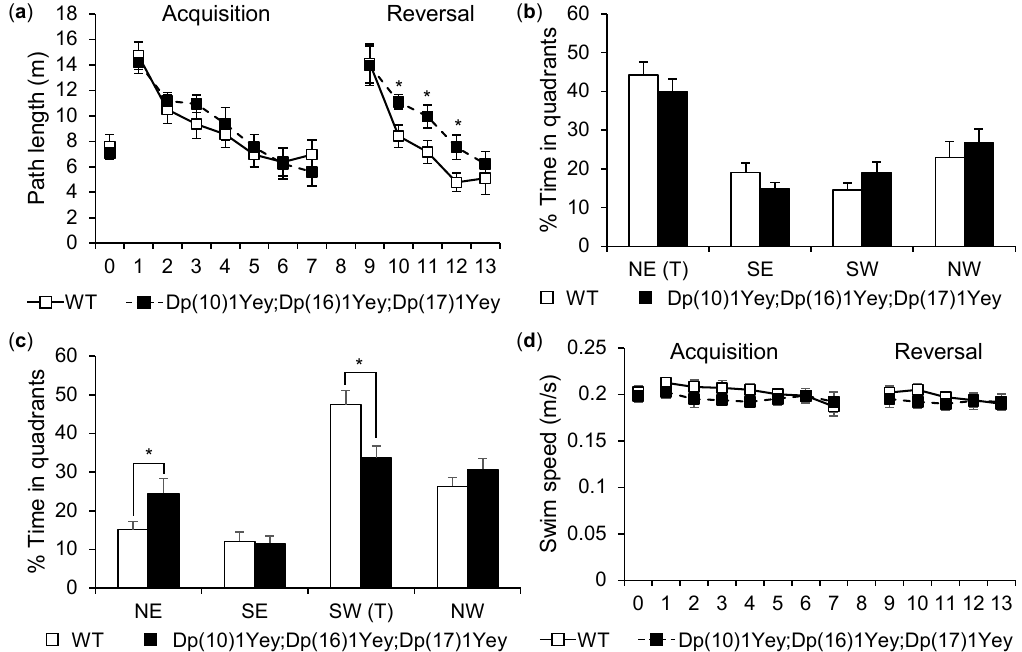
Figure 8. Morris water maze test: Dp(10)1Yey;Dp(16)1Yey;Dp(17)1Yey mice and the wild-type control mice were compared in a Morris water maze test. ( a ) During the hidden platform test from day 1 to 7, no differences in the path-lengths taken to reach the platform were observed between the mice carrying two different genotypes (*, p > 0.05). During the reverse platform test from day 9 to 13, the path-lengths taken to reach the platform were longer for Dp(10)1Yey;Dp(16)1Yey;Dp(17)1Yey mice than those for the wild-type control mice (*, p < 0.05). ( b ) In the probe test on day 8, no differences in the times spent in the target quadrant were observed between the mice carrying two different genotypes ( p > 0.05). ( c ) In the reverse probe test on day 14, differences in the times spent in the target quadrant were observed between the mice carrying two different genotypes (*, p < 0.05). ( d ) There was a small difference in swimming speed between the mice carrying two different genotypes ( p < 0.05).